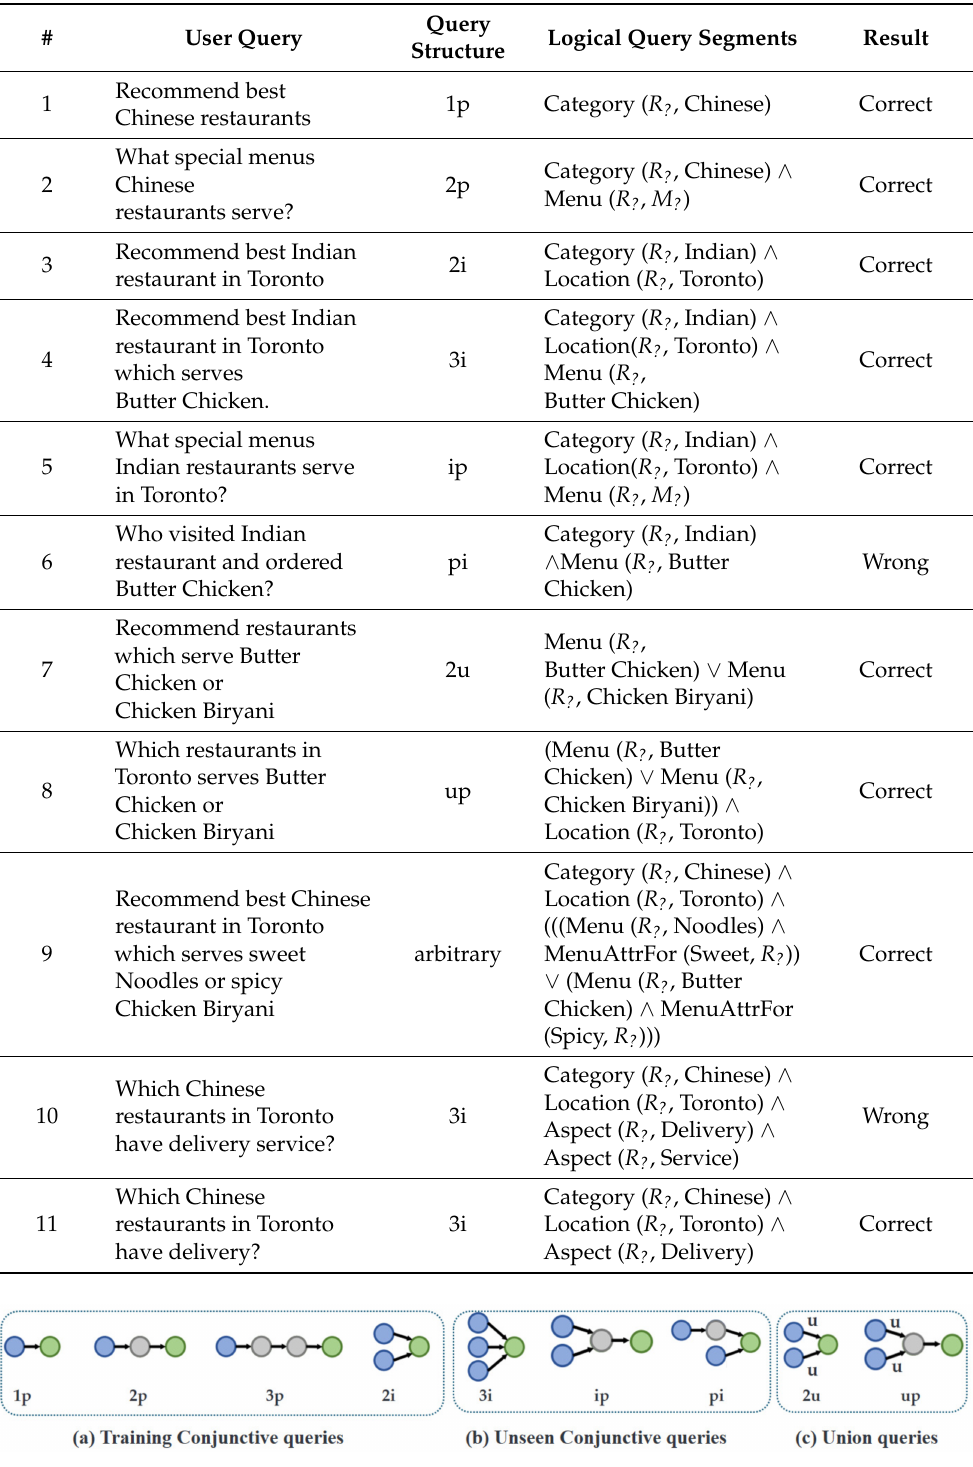
Figure 8. Query structures for experiments, where ‘p’, ‘i’, and ‘u’ stand for ‘projection’, ‘intersection’, and ‘union’,